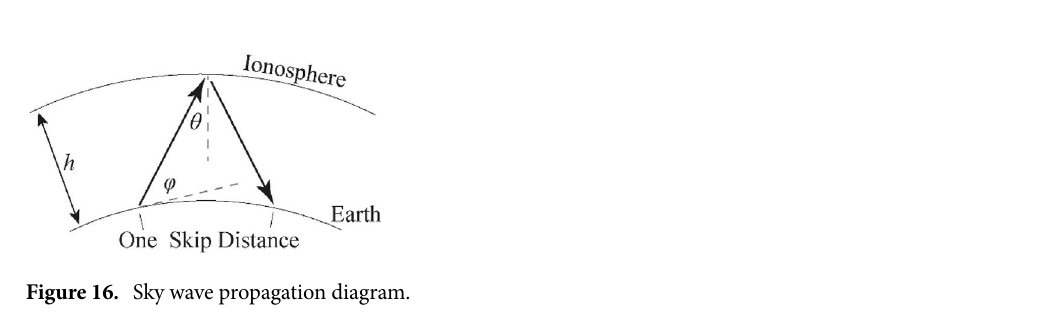
Figure 15. Multiprobe near-field measurement system.